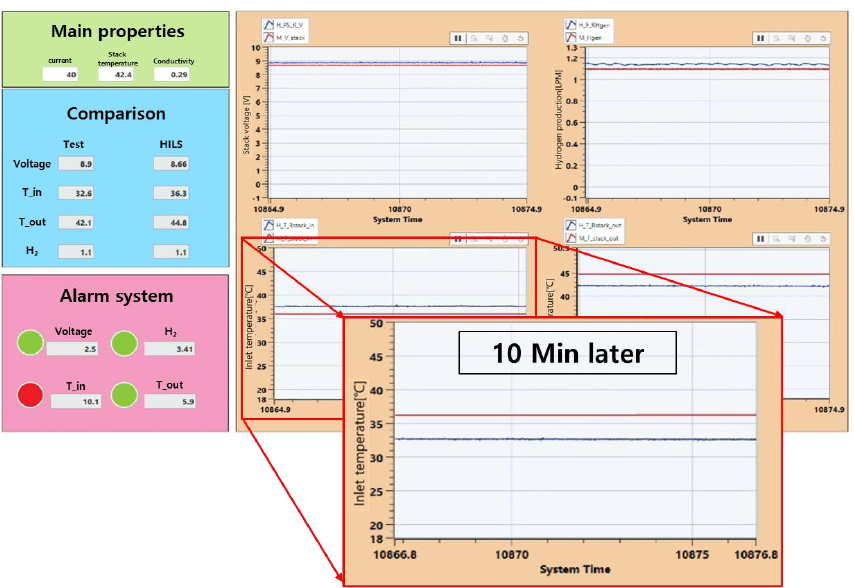
Figure 12. GUI of HILS-based fault-detection system.